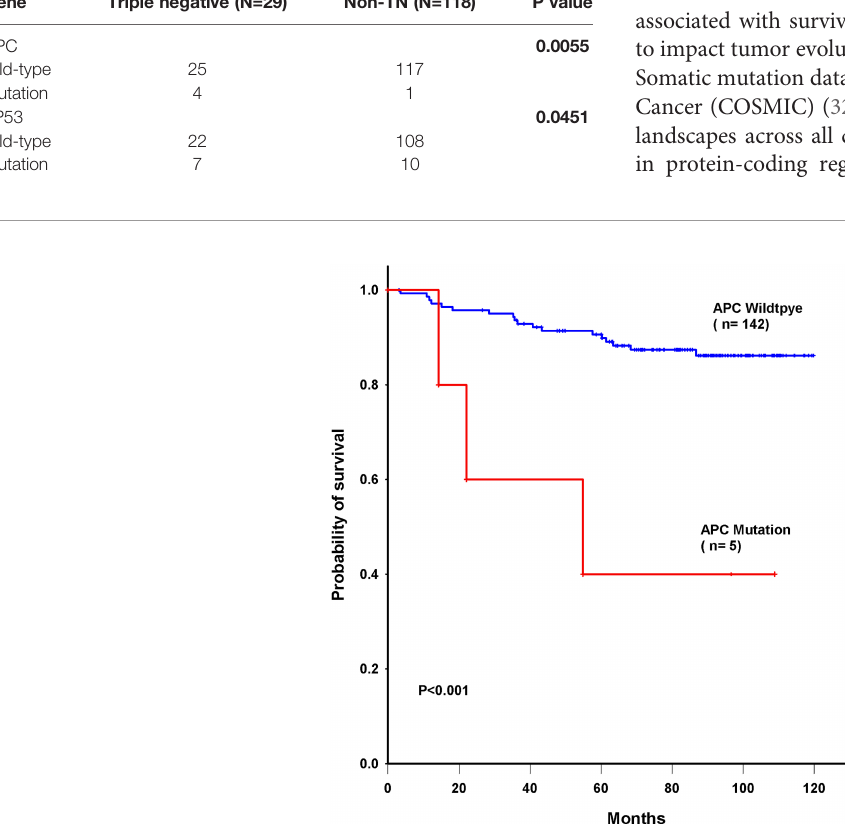
FIGURE 6 | Kaplan – Meier survival curves for overall survival based on APC mutations in breast cancer